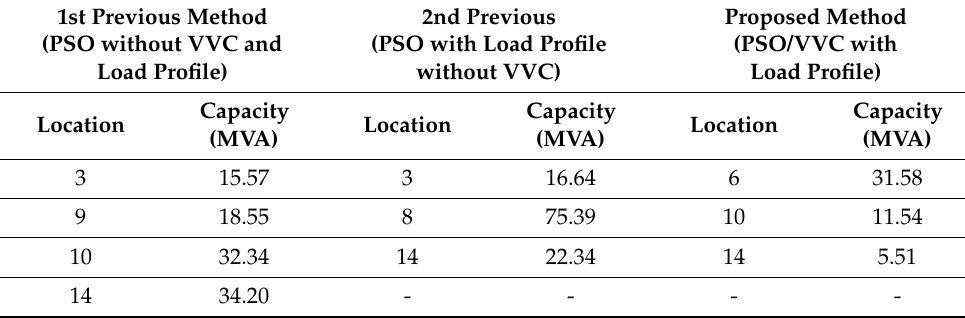
Figure 12. Line losses profile. Table 4. Location and capacity of DG systems for the IEEE 14-bus test Table 5. Value of the objective function (the IEEE 14-bus test feeder).